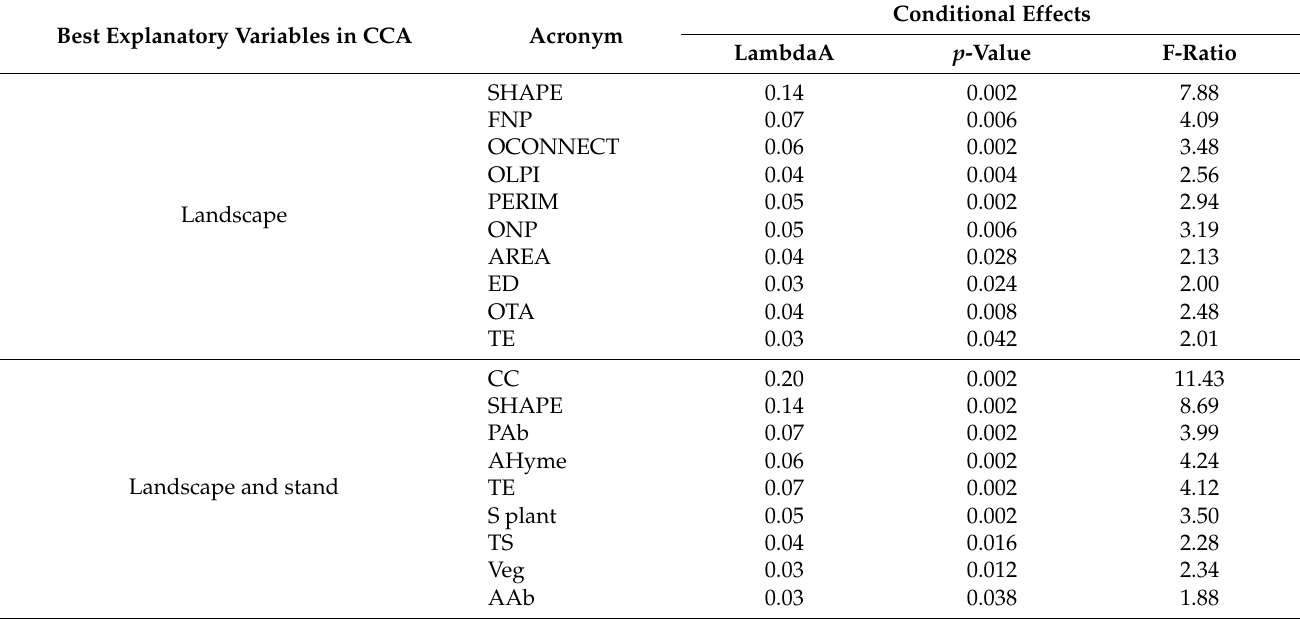
Table 4. Results of Canonical Correspondence Analysis (CCA) showing the importance of landscape variables and stand characteristics (habitat structure and food availability) in explaining variation in species composition for Nothofagus antarctica forests in Tierra del Fuego (Argentina), as is showed by their conditional effects. Units of variables are showed in Table 1 and Appendix